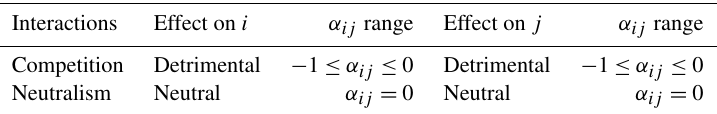
Figure 2. Illustration outlining pyReef-Core workflow (a) and of the resulting simulated core (b) . First boundary conditions for sea level, sediment input and flow velocity are set, which describes their relationship to either depth or time. The boundary conditions are used to establish the environment factor f env , which describes the proportion of the maximum growth rate that an assemblage can achieve, depending on whether the environmental conditions exceed the optimal conditions for growth. The environment factor is scaled by the Malthusian parameter, which is in turn used as input in the GLVEs to determine assemblage populations. Larger assemblage populations contribute to a faster rate of vertical accretion (here referred to as carbonate production). At the end of the time step, boundary conditions are updated and the process is repeated. Table 1. Interaction possibilities among coral assemblages and the associated range of matrix coefficients, adapted from Clavera-Gispert et al.